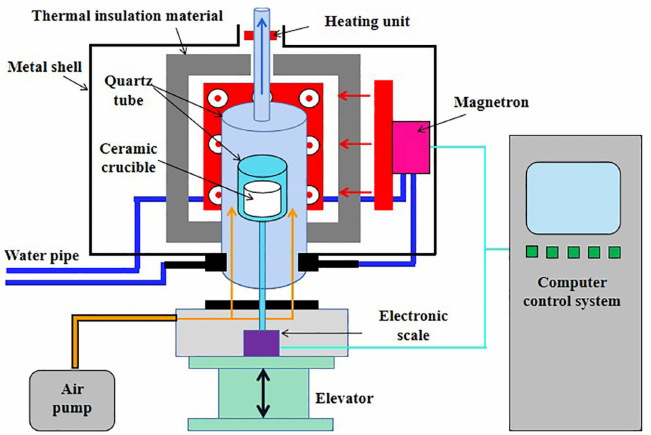
Figure 2. Schematic illustration of microwave thermogravimetric